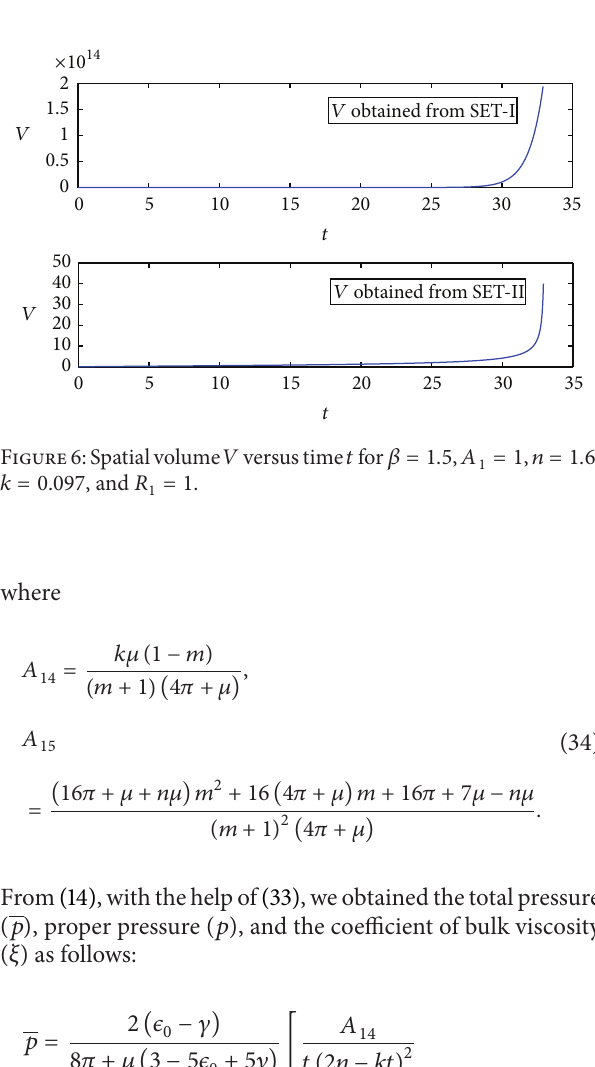
Figure 5: Hubble parameter 𝐻 versus time 𝑡 for 𝛽 = 1 . 5, 𝐴 1 = 1, 𝑛 = 1 . 6, and 𝑘 = 0 . 097.